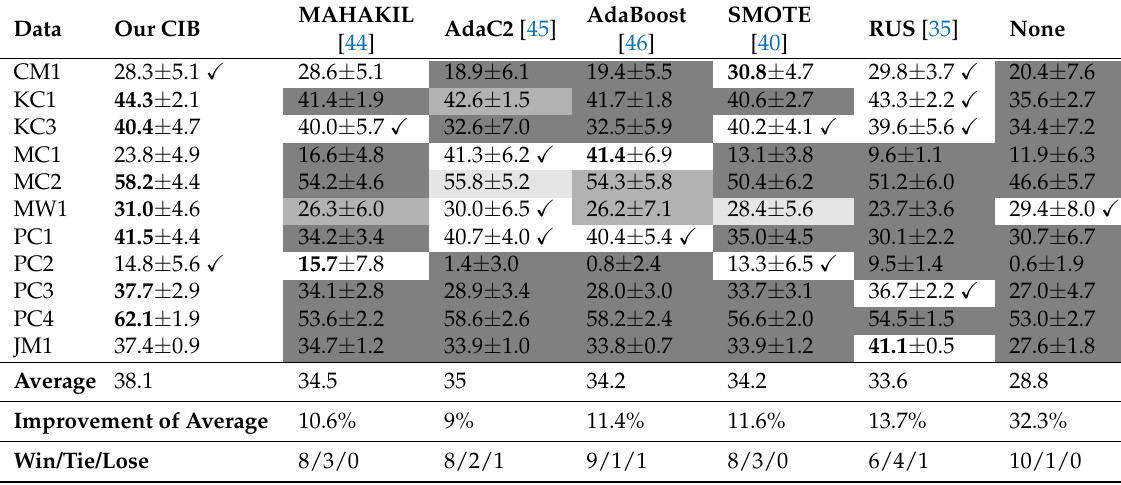
Table 4. The comparison results of F 1 for all methods in the form of mean ± standard deviation. The best value is in